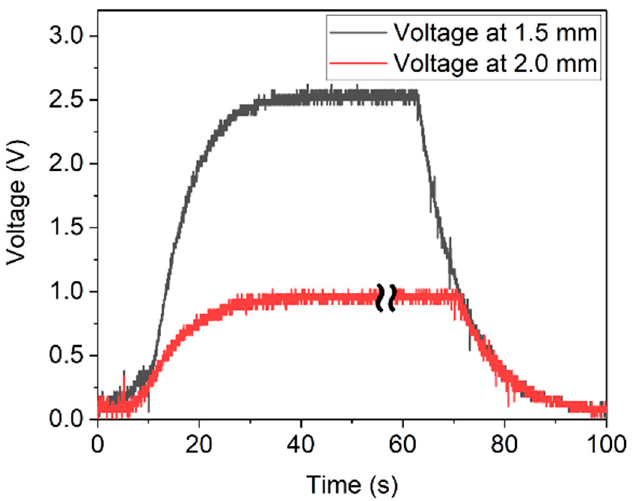
Figure 22. Charging and discharging curve of the capacitors resulting from magnetic plucking at distances of d = 2.0 mm (red curve) and d = 1.5 mm (black curve). Some data are skipped in the plateau of the red curve to align the timeline of both graphs.